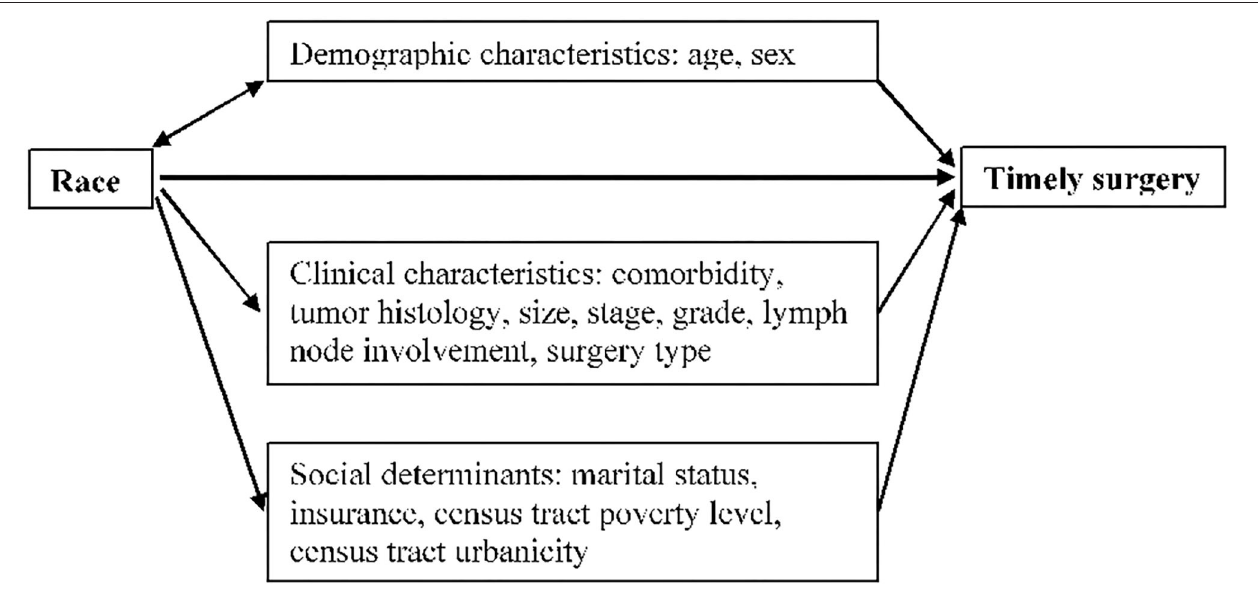
FIGURE 1 | Conceptual diagram of racial disparity in receiving timely surgery for non-small cell lung cancer